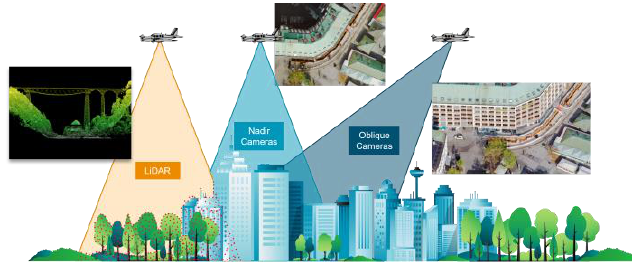
Figure 8: Hybrid data acquisition - Sensor sub-systems contribute to urban